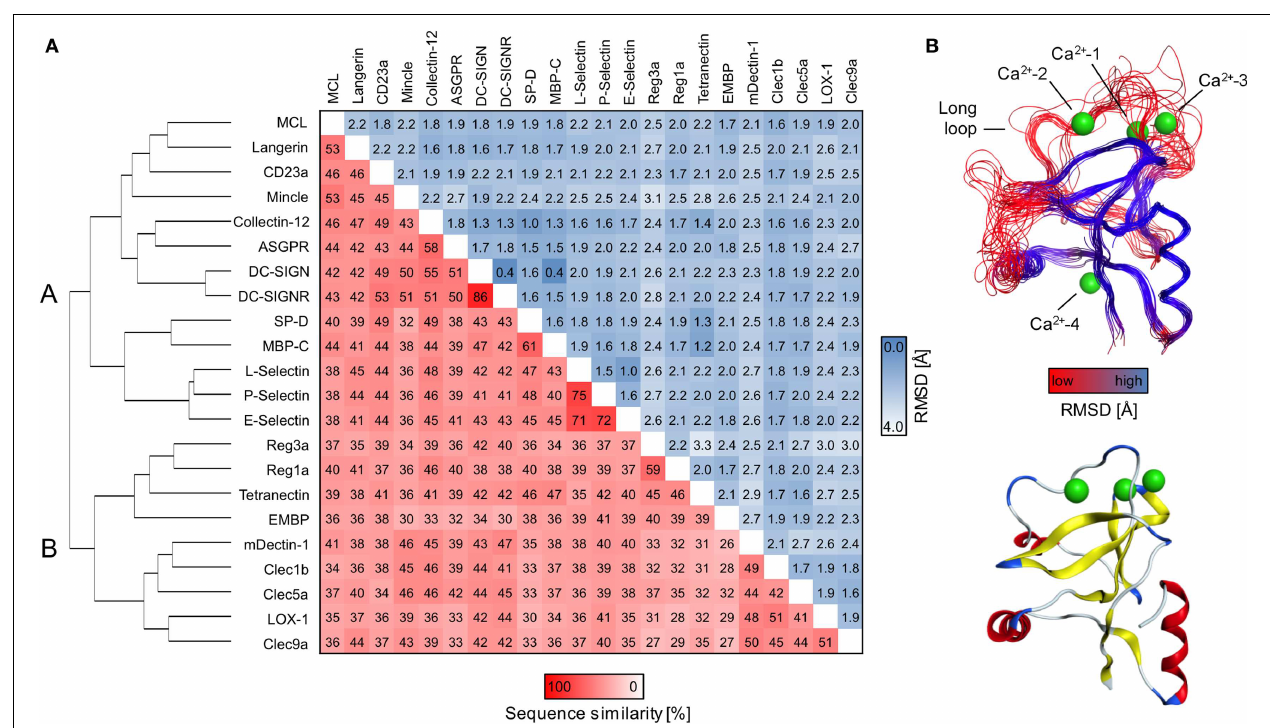
fold are mapped on the predicted consensus structures (top).The peptide backbone is displayed as a continuous line and colored according to RMSD of C α atoms.The CRD of DC-SIGN (PDB code: 2XR6) is shown for comparison (bottom).The ribbon representation is colored according to secondary structure elements (red: α -helices; yellow: β -strands; blue: loop